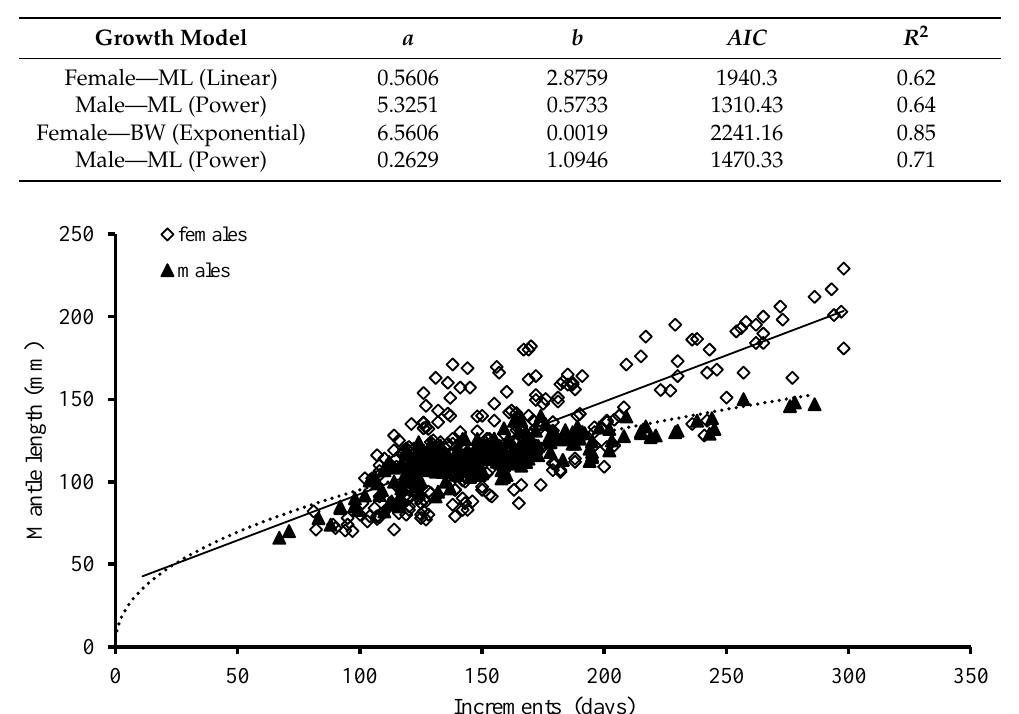
Figure 7. Relationships between mantle length (ML) and age for S. oualaniensis in the waters of the Xisha Islands of the South China Sea.